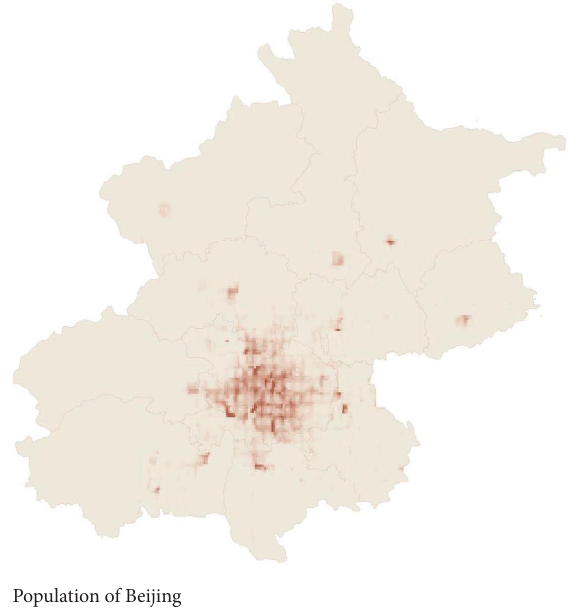
Figure 7: Heat map of population distribution in Beijing.